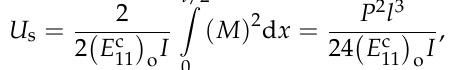
Figure 11. Relationship between the output voltage and time in cyclic bending.